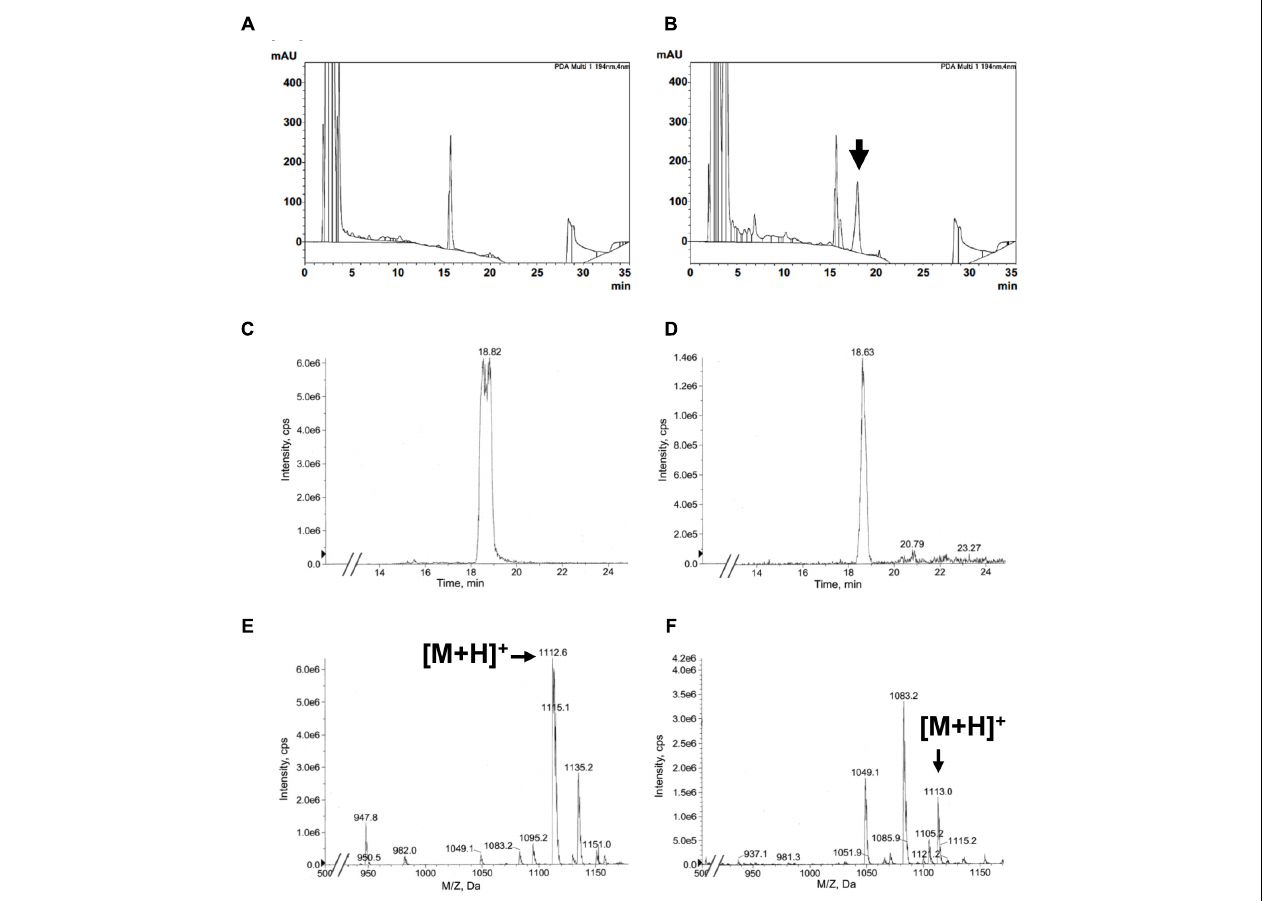
FIGURE 6 | KK-1 production, and confirmation of production, in A. oryzae . (A,B) HPLC UV spectra of (A) extract of supernatant from culture of the A. oryzae CNT strain and (B) extract of supernatant from culture of strain 54, into which all genes were successfully introduced. UV spectrum of the peak indicated by the arrow is identical to that of standard KK-1 derived from Curvularia clavata . (C,D) Extracted ion chromatograms ( m/z 1113). (C) Standard KK-1 derived from Curvularia clavata . (D) Extract of supernatant from culture of A. oryzae strain 54. (E,F) Mass spectra of KK-1. (E) Standard KK-1 derived from Curvularia clavata . (F) Extract of supernatant from culture of A. oryzae strain